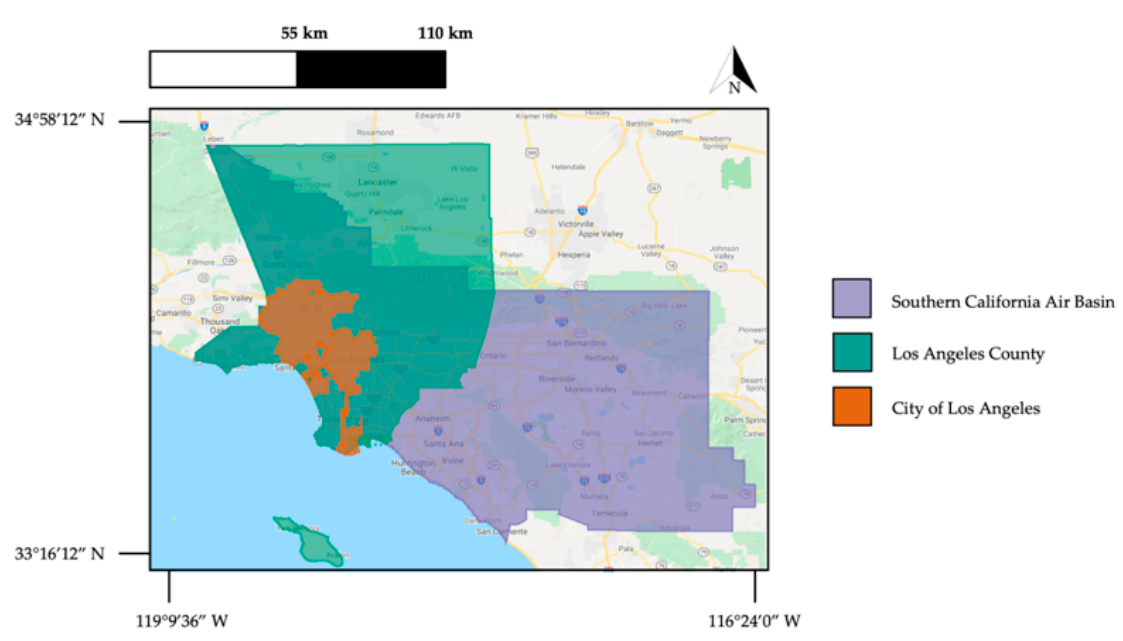
Figure 1. Spatial relationship of SoCAB to census-designated City of Los Angeles and Los Angeles County within southern California. High-resolution land cover classification is needed across SoCAB for accurate CO2 flux inversion modeling, but available maps at an adequate resolution for flux quantification only cover the City of Los Angeles or Los Angeles County.